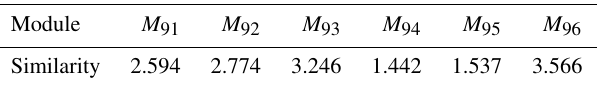
Table 8. Similarity of each cutter disc module.